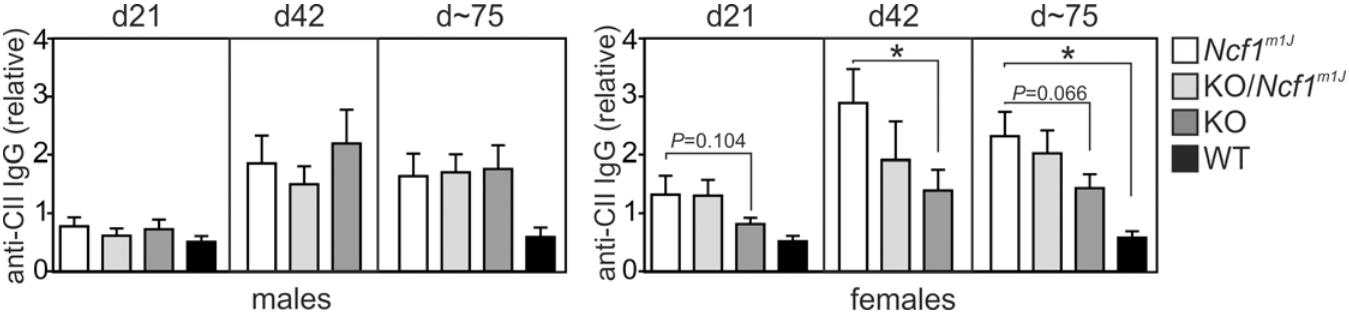
Fig 3. Antibody (IgG) response to type II collagen (CII) in the serum during CIA. Number of days post immunization is indicated above (d~75 referring to sera collected either 71 or 77 days after the immunization). The data (d21 and d~75) were pooled from two independent experiments. Day 42 (d42) data was only available from one of those experiments. * P < 0.05 when calculated by Student ’ s t-test. The results are presented as mean +/-SEM, n = 4 –